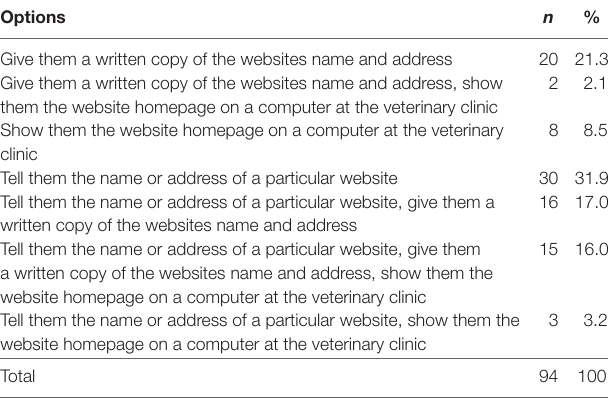
taBlE 2 | Methods in which veterinarians recommend website to clients ( n = 94). Options